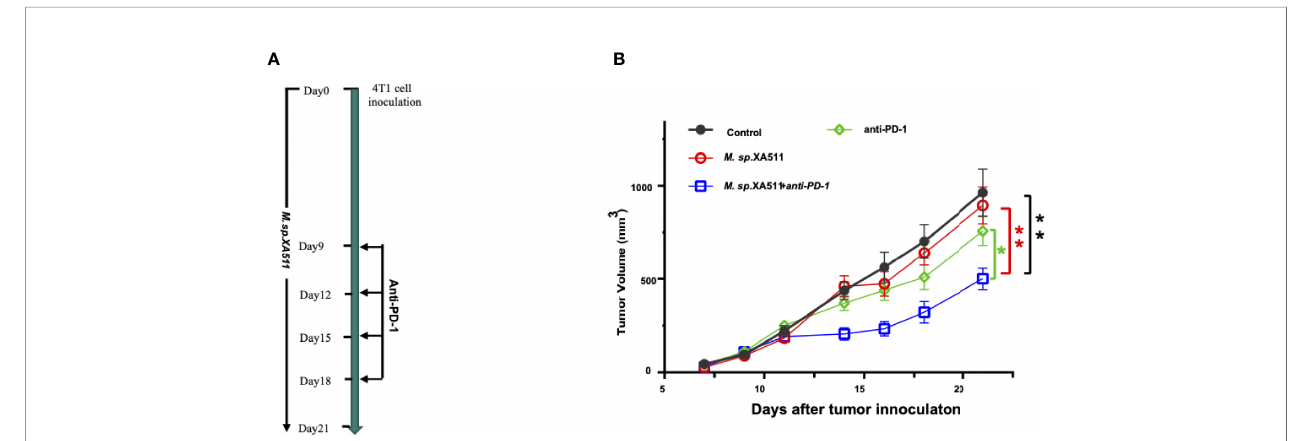
FIGURE 5 | Megasphaera sp. XA511 (M.sp.XA511) enhances the ef fi cacy of PD-1 blockade in vivo . (A) Experiment design of the mouse study. 6-week-old SPF Balb/c mice bearing 4T1 tumors were administrated with Megasphaera sp. XA511 daily, Isotype or anti-PD-1 antibodies were administered to the animals on days 9, 12, 15 and 18 by intraperitoneal injection. (B) Tumour volumes were measured on day7, day9, day11, day14, day16, day18 and day21 after inoculation of tumour cells. Tumor size data were analysed and expressed as the mean ± standard deviation. The one-way ANOVA was used to determine whether there are any statistically signi fi cant differences between the means of PD1 combined with Megasphaera sp. XA511 and other groups. The black, red, green, and blue colour indicate Control, Megasphaera sp. XA511 , antiPD1 and antiPD1 combined with Megasphaera sp. XA511 group respectively. The asterisk indicates signi fi cant difference (*P < 0.05, **P <